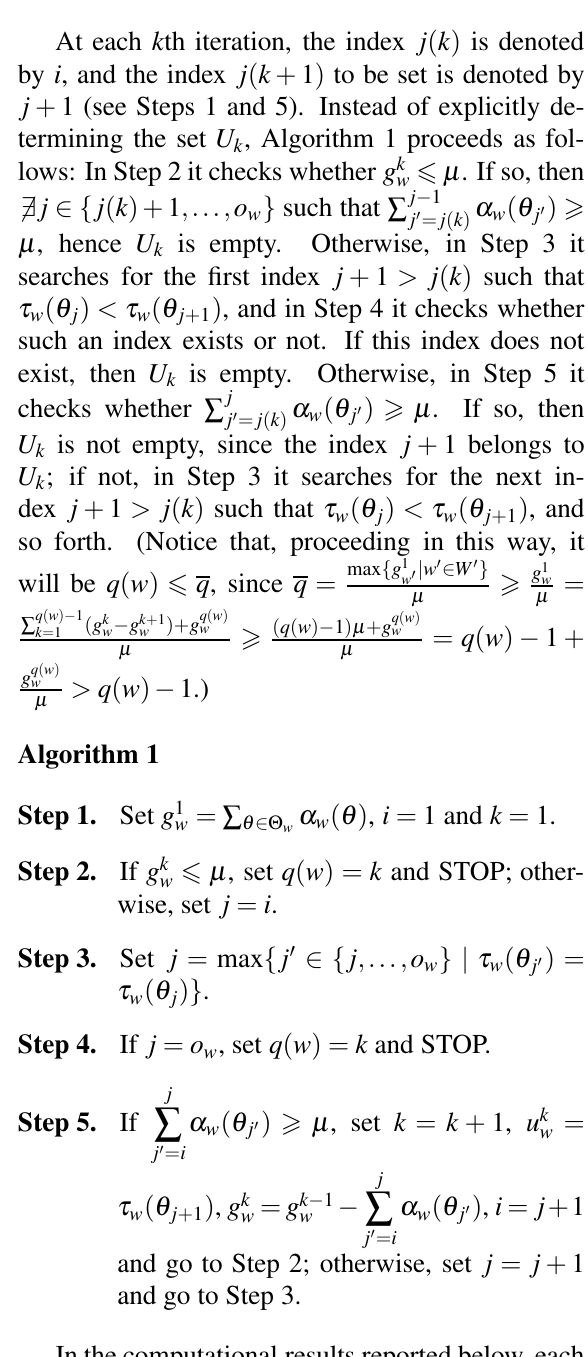
= t (cid:5) ( w )+ t (cid:5) n − 1 w